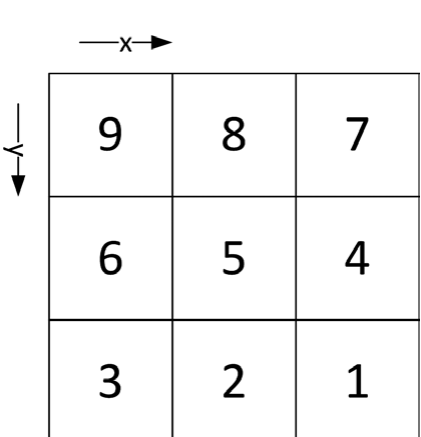
Fig. 2. A 3*3 window with numbered cells. The number in the cell is to identify each cell in presented equations, and the f and f represent the x and y perpendicular y